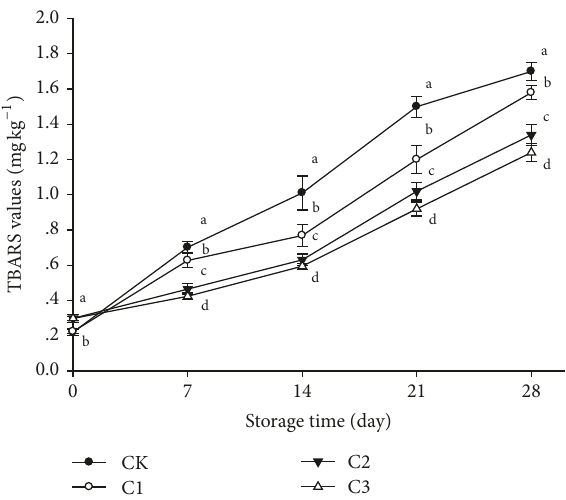
Figure 6: Changes in TBARS of beefsteaks with different treatments during storage. CK, the group of beefsteaks without pretreatments; C1, the group of beefsteaks pretreated with 100% CO for 1.5h; C2, group of beefsteaks pretreated with 100% CO for 1.5 h and soaked in 50 mg/L ClO 2 ; C3, group of beefsteaks pretreated with 100% CO for 1.5 h and soaked in 50 mg/L ClO 2 for 10min and sprayed with 30 g/L lactic acid. Data were represented with mean values ± Standard Error; sometimes the bars were too small to see. Different letters mean significant difference of samples with different treatments on the same storage days ( 𝑃 < 0.05 ). Three separate steaks of each treatment were measured; three repetitions were performed for each treatment. 𝑛 = 9